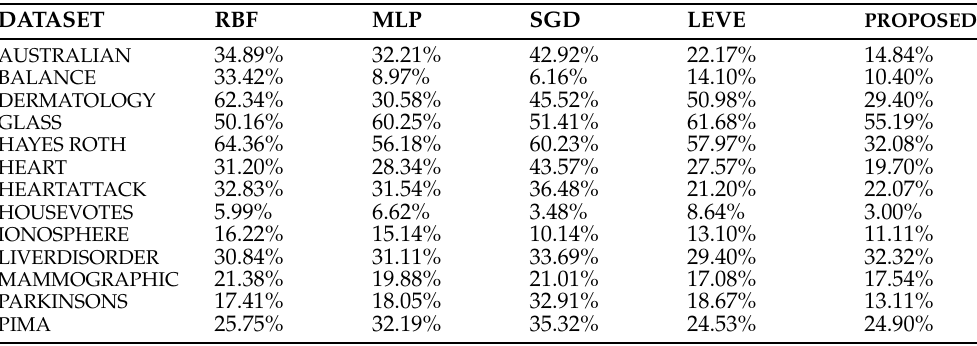
Table 2. Experiemental results for classification